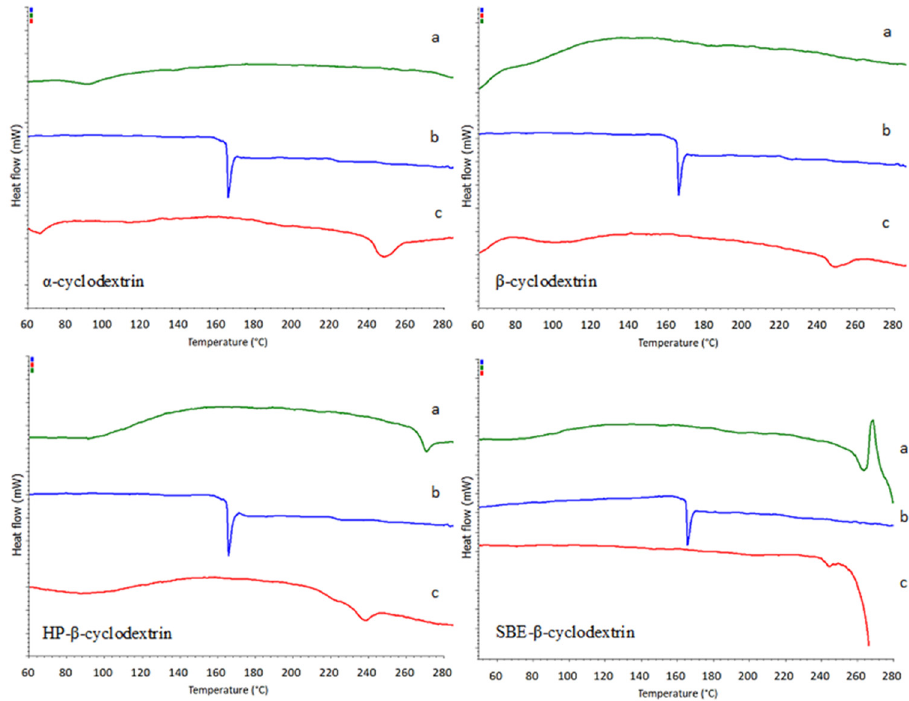
Figure 5. Differential scanning calorimetry thermograms of: cyclodextrin ( a ), ezetimibe ( b ) and ezetimibe/cyclodextrin complex 1:1 ( c ).